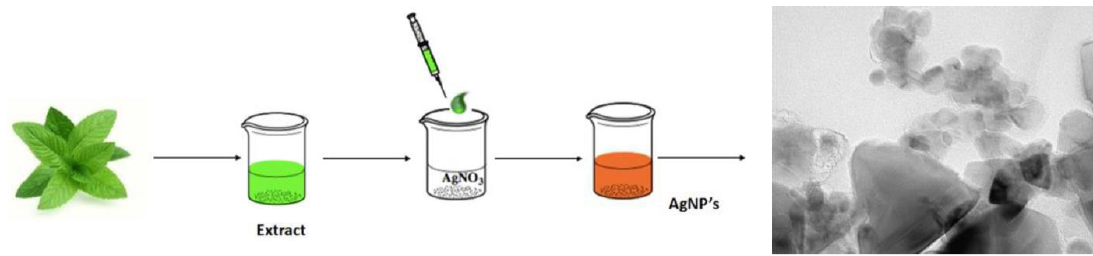
Figure 2. Synthesis of silver nanoparticles (AgNPs) using natural extracts from wastes.